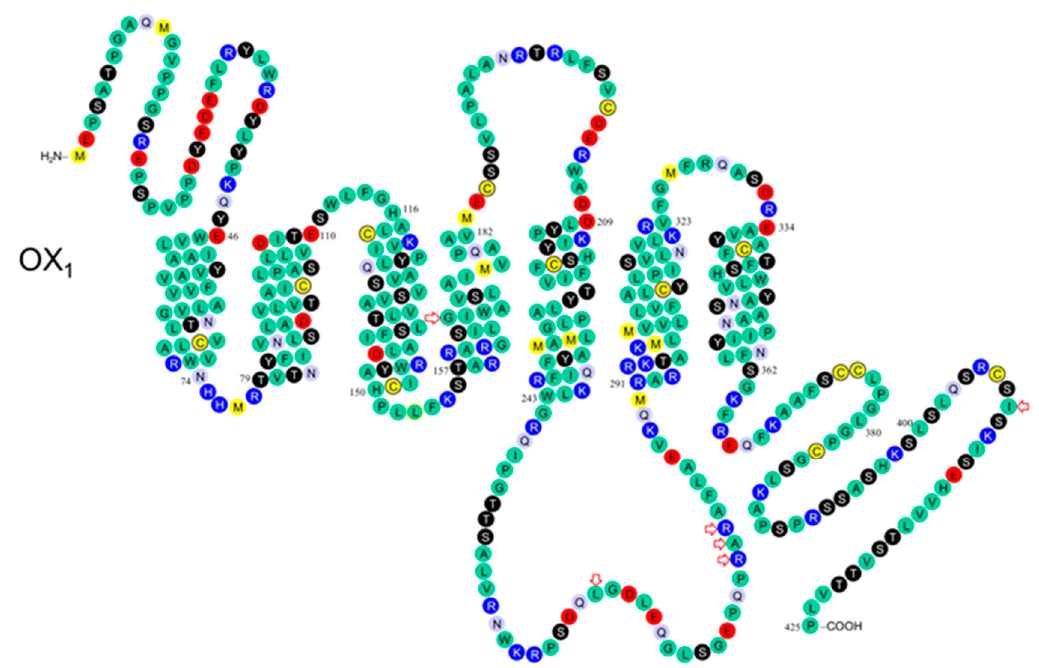
Figure 2. Schematic of the OX 1 receptor in the plasma membrane. Modified from Kukkonen et al. [23]; based on findings of Peyron et al. [10] and Olafsdottir et al. [9]. The variants marked with red arrows are: OX 1 167 Gly/Ser, OX 1 265 Leu/Met, OX 1 279 Arg/Glu, OX 1 280 Ala/Gly, OX 1 281 Arg/His, OX 1 408 Ile/Val [2].